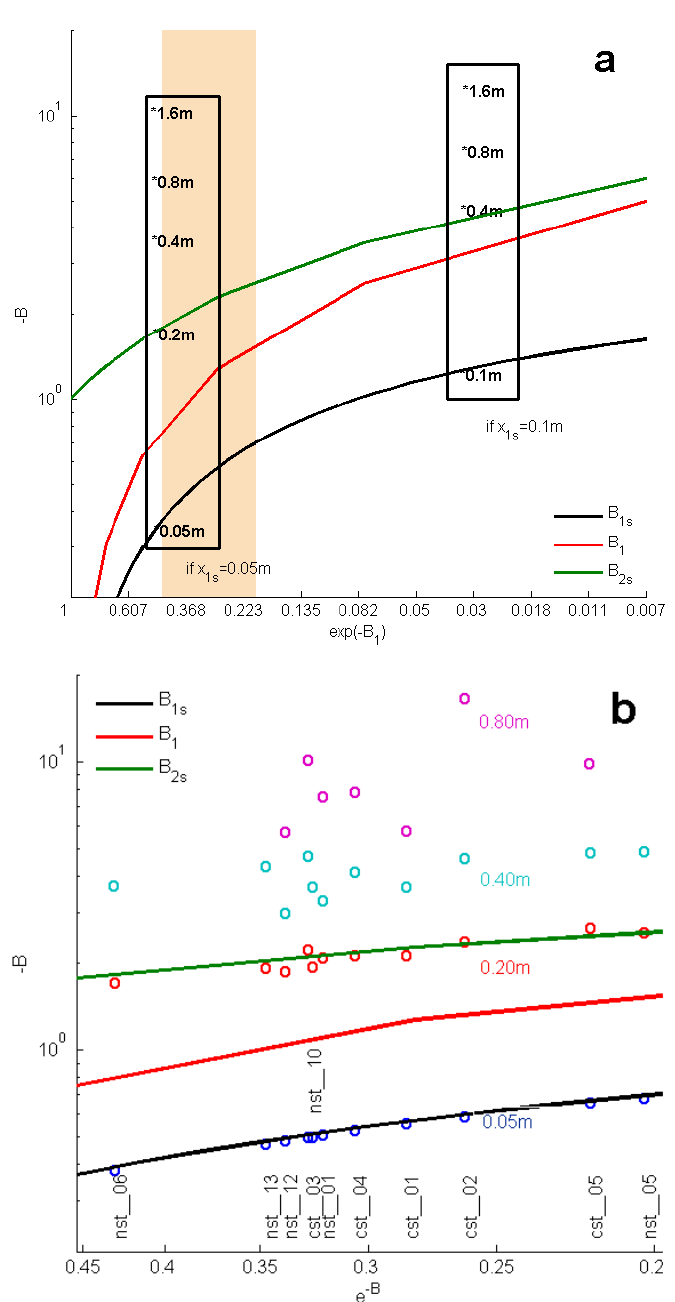
Figure 6. ( a ) An illustration of the ratios for B 1 s { B 1 { B 2 s at the center station when 5 cm and 10 cm are taken as the first layer in the Maqu Network. The shaded area depicts the e ´ B range used for Figure 6b; ( b ) The other sites in the Maqu Network with 5 cm as the first layer and assuming 20 cm/40 cm/80 cm to be the second layer. 10 cm is not included for the same reason shown in the left column of Figure 6a.